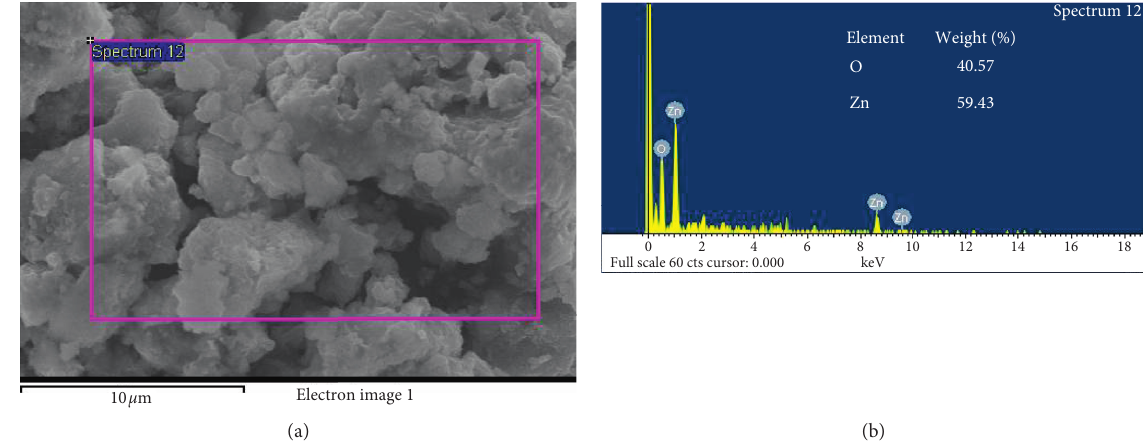
Figure 4: SEM images of selected area for EDX spectra of (a) 1:1 UZnO EDX and (b) quantitative